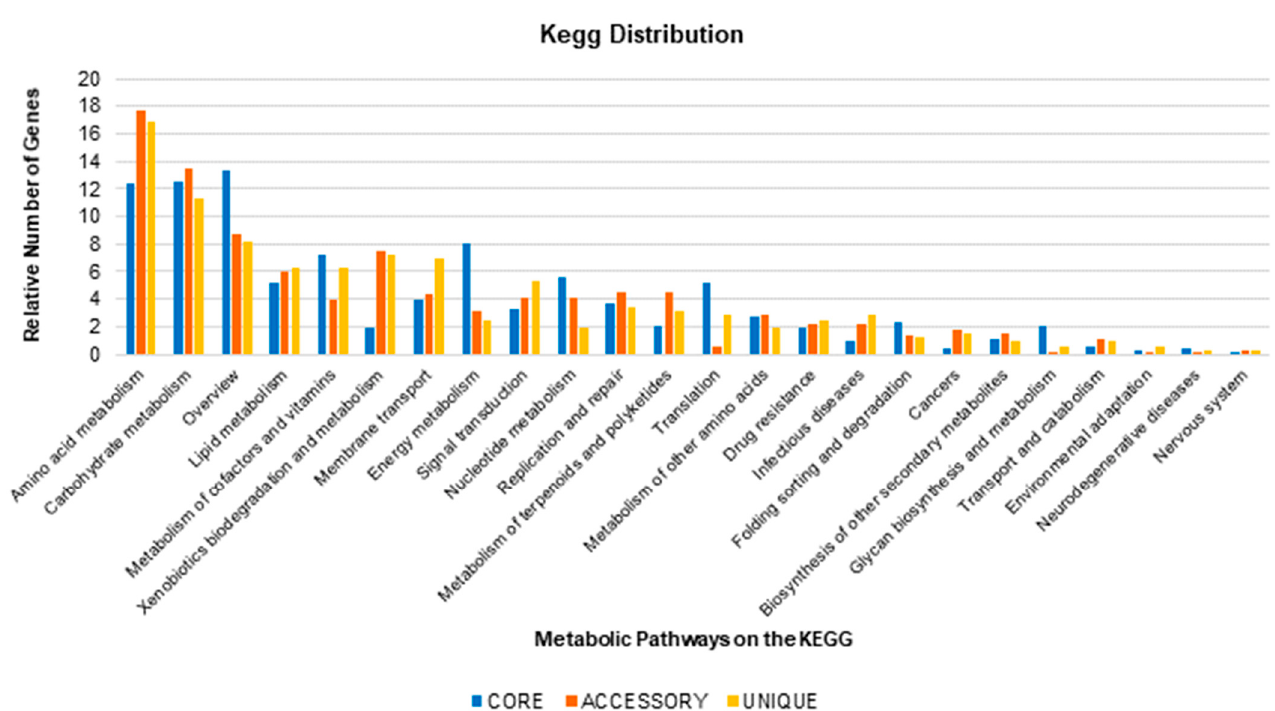
Figure 5. Graphical representation of the gene distribution by metabolic pathway within each subpartition of the total pan-genome. Only pathways with at least 0.1% of the genes represented in each subpartition of the pan-genome were considered.